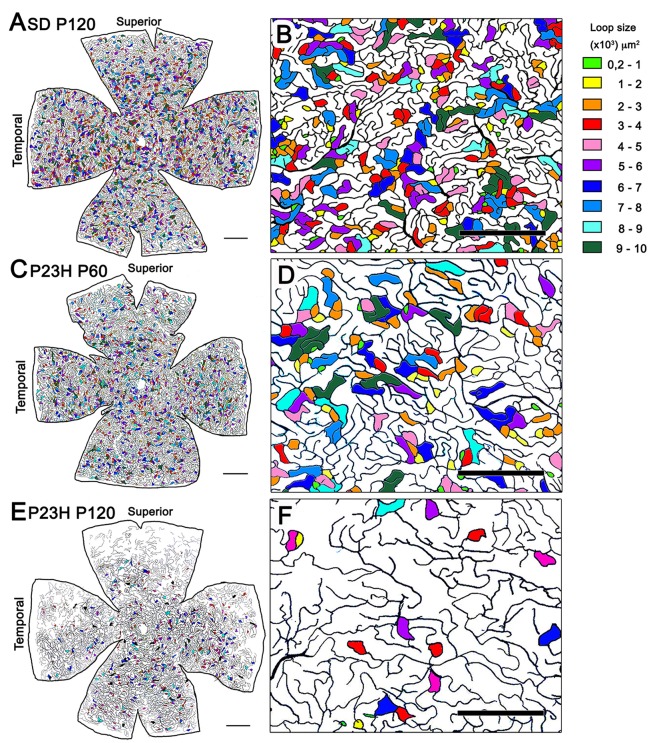
Capillary loop size and distribution in the DCP in P23H rats. (A,C,E) Representative drawings of the blood vessels in the DCP of a P120 SD rat (A) and P23H rats at P60 (C) and P120 (E) showing capillary loop size ranges from 200 μm2 to 10,000 μm2. To better visualize the relationship between capillary loop size and distribution, the area circumscribed within each loop has been labeled in different colors depending on their relative size. (B,D,F) Higher magnifications of the panels (A,C,E) respectively, corresponding to representative areas of the medial superior retina. Units on the right of the figure indicate the loop size ranges in μm2. Note the progressive reduction in capillary loop density in P23H rats. Scale bar: 1 mm for (A,C) and (E); 500 μm for (B,D,F).